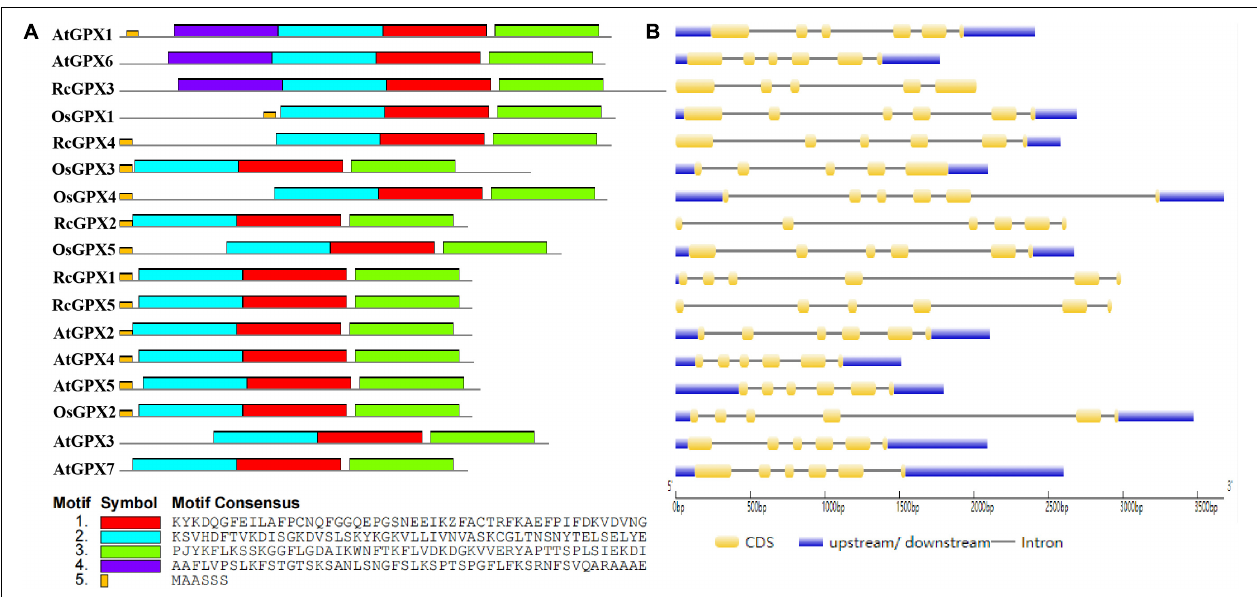
FIGURE 2 | Conserved motifs and gene structures of GPXs from the castor bean, rice, and Arabidopsis. (A) Conserved motifs were identified by MEME, and their distribution was presented by different colors. (B) Exon/-intron organization was analyzed by GSDS software. The yellow round-corner rectangles indicated exons, the black lines indicated introns, and the blue rectangles indicated untranslated regions. GPXs, glutathione peroxidases; GSDS, Gene Structure Display